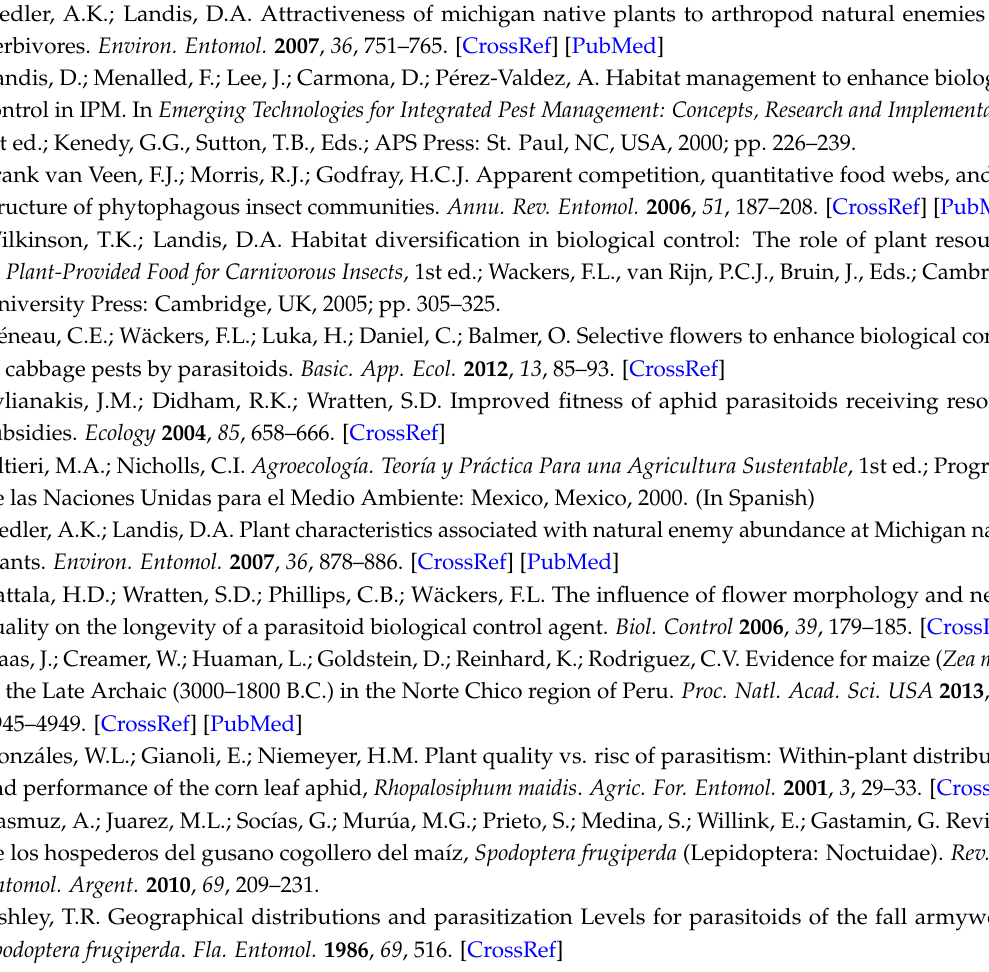
Table S1: Abundance of all insect species in every plant